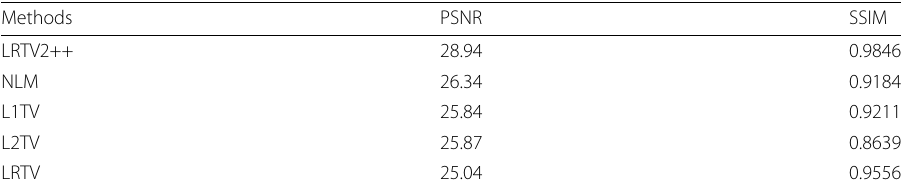
Table 2 PSNR and SSIM index values of each method for image (HEADNECK)